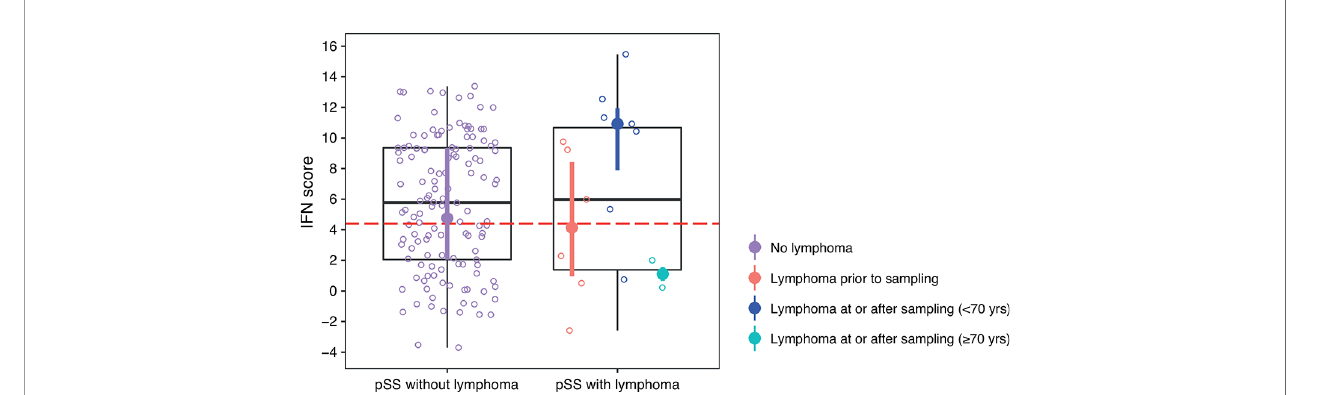
FIGURE 5 | DNAm IFN score levels in patients with pSS strati fi ed for lymphoma, discovery and replication cohort together. Dotted red horizontal line indicates threshold for high IFN score. Boxes represent median and interquartile range, whiskers indicate total range. pSS patients without lymphoma indicated in purple in the left panel. In the right panel pSS patients with lymphoma strati fi ed for lymphoma prior to DNA sampling (in red), lymphoma at or after DNA sampling in patients < 70 years of age at lymphoma diagnosis (in dark blue), and lymphoma at or after DNA sampling in patients ≥ 70 years of age at lymphoma diagnosis (in light blue). DNAm IFN score median and interquartile range for each of the pSS subgroups are indicated by fi lled circles and vertical lines colored according to the corresponding patient